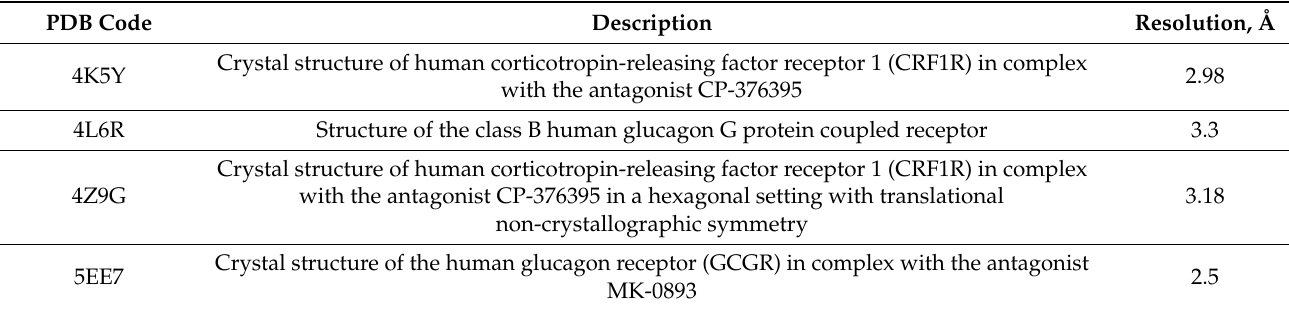
Table A2. A list of all family B structures used in Figure 4. Included are the PDB code, description, and resolution in Ångströms. Structure 6FJ3 was not included in analyses due to unusable annotation and 6ORV was not included due to PDB